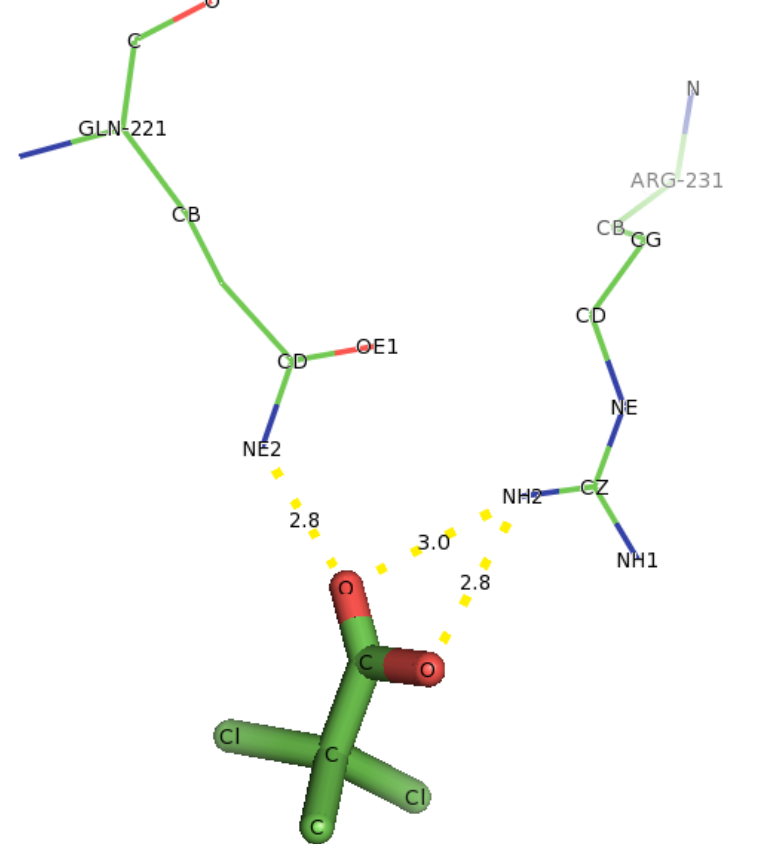
Figure 21. The interacting residues of DehD with 2,2-DCP. Hydrogen bond distances are in